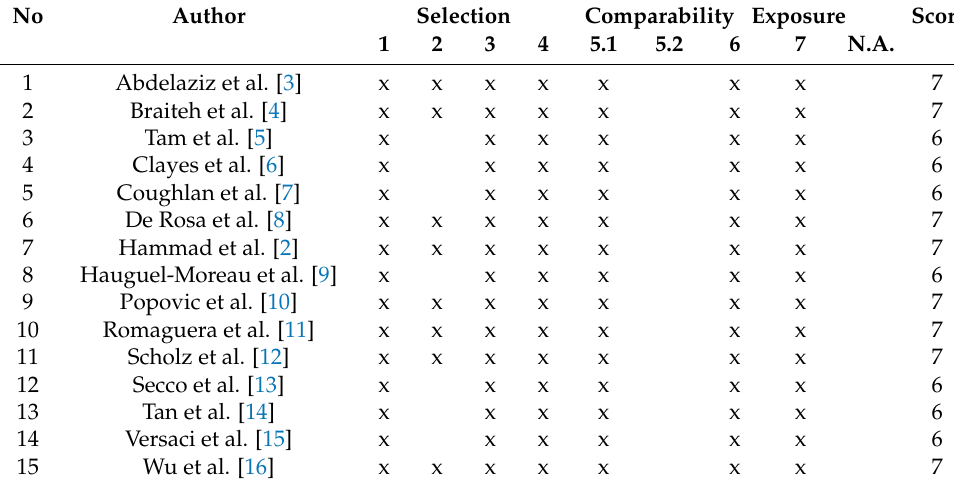
Table 2. Quality assessment using Newcastle–Ottawa scale. No Author